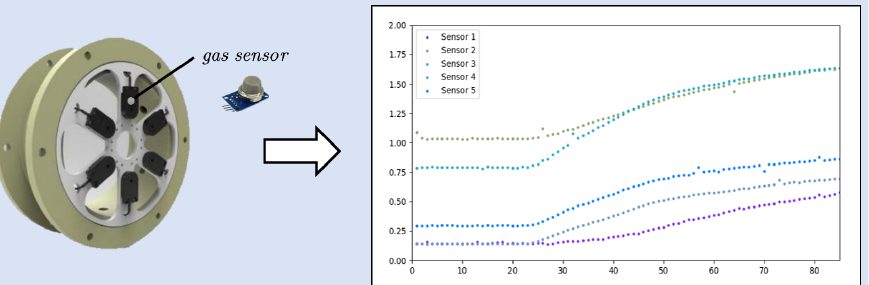
Figure 2. Sample response curve.